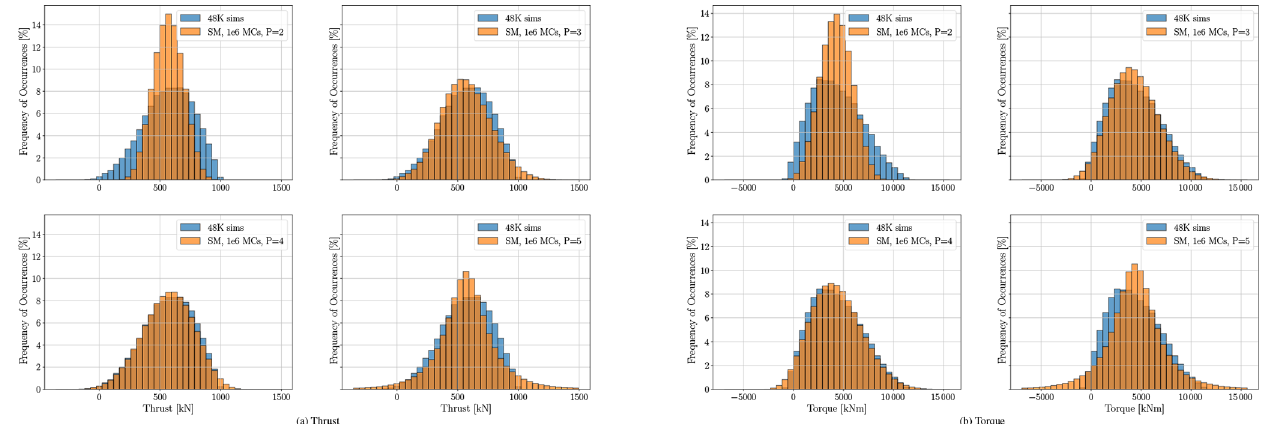
Figure 6. Thrust and torque surrogate models with 1 million MCSs vs. the reference case